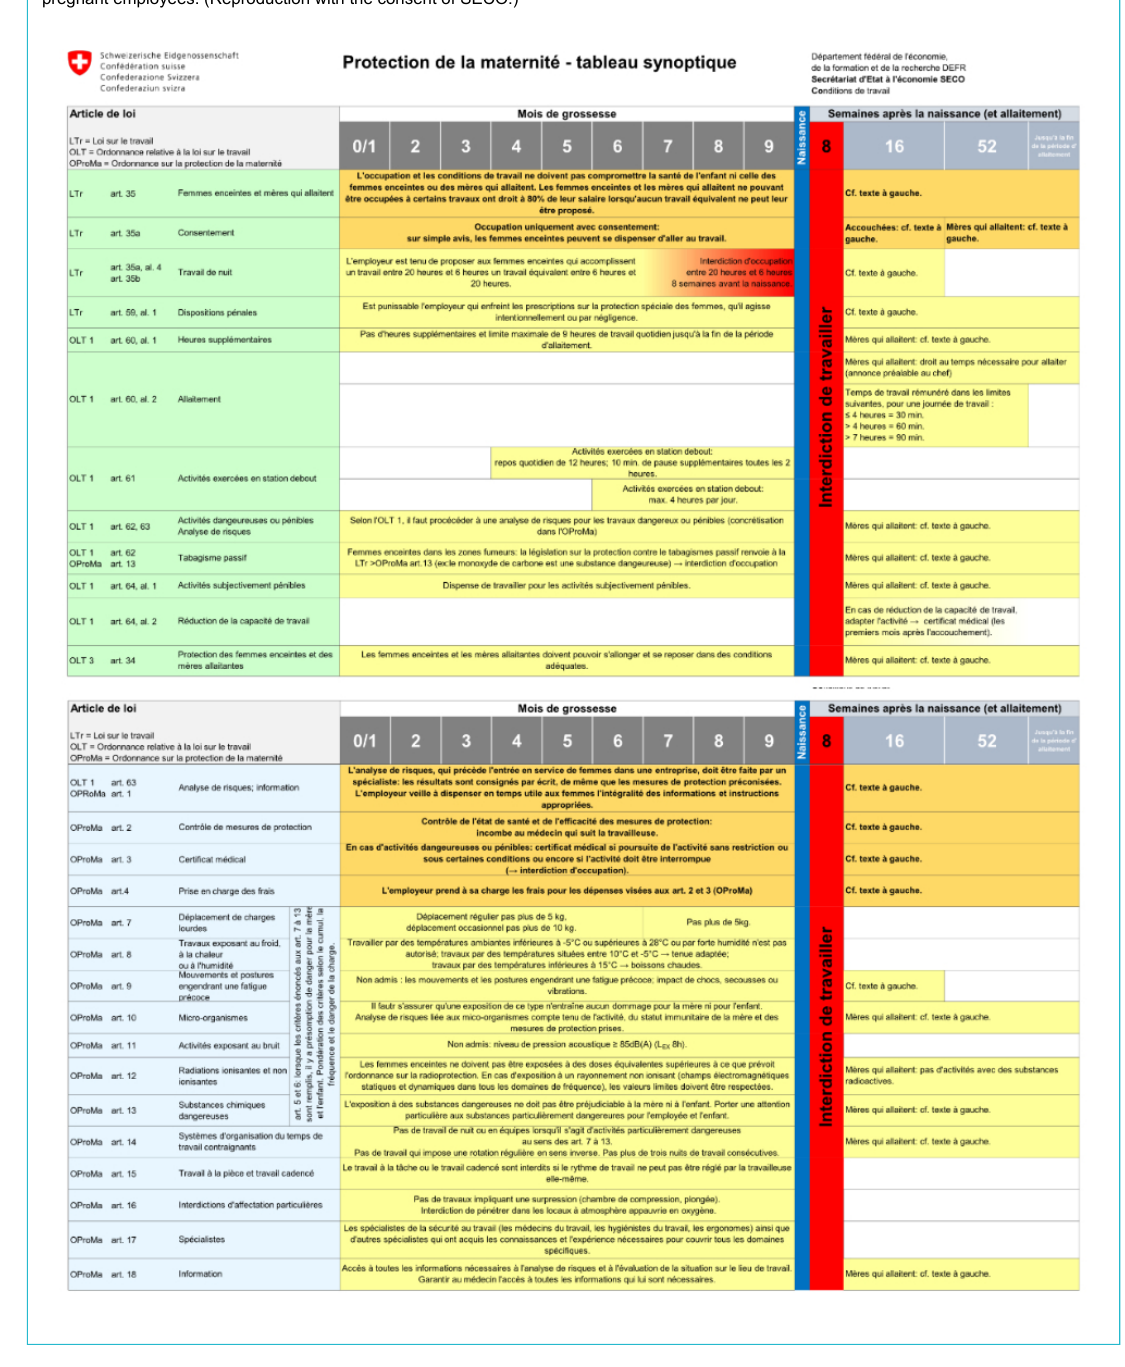
Figure 1: Switzerland’s State Secretariat for Economic Affairs’ (SECO) [39] table summarising work organisation and dangerous activities for pregnant employees. (Reproduction with the consent of